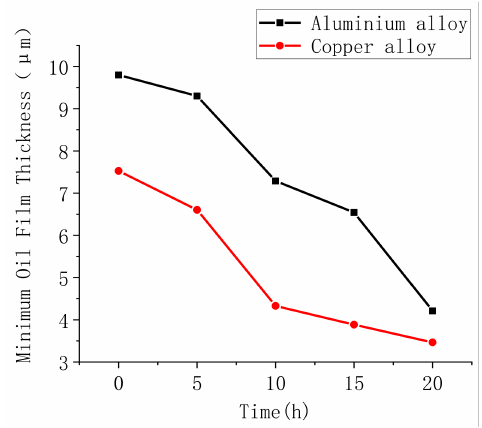
Figure 15. Comparison of minimum oil film thickness for different wear test